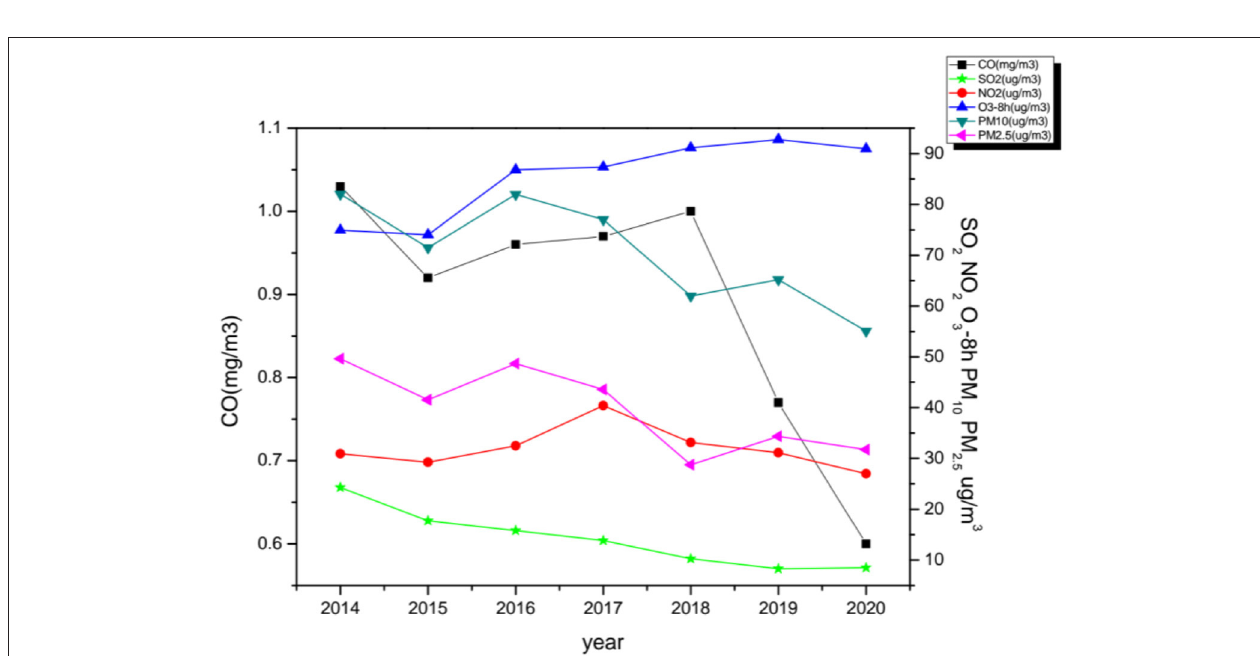
FIGURE 2 | The annual change trend of air pollutants in Nanchang city, 2014–2020.